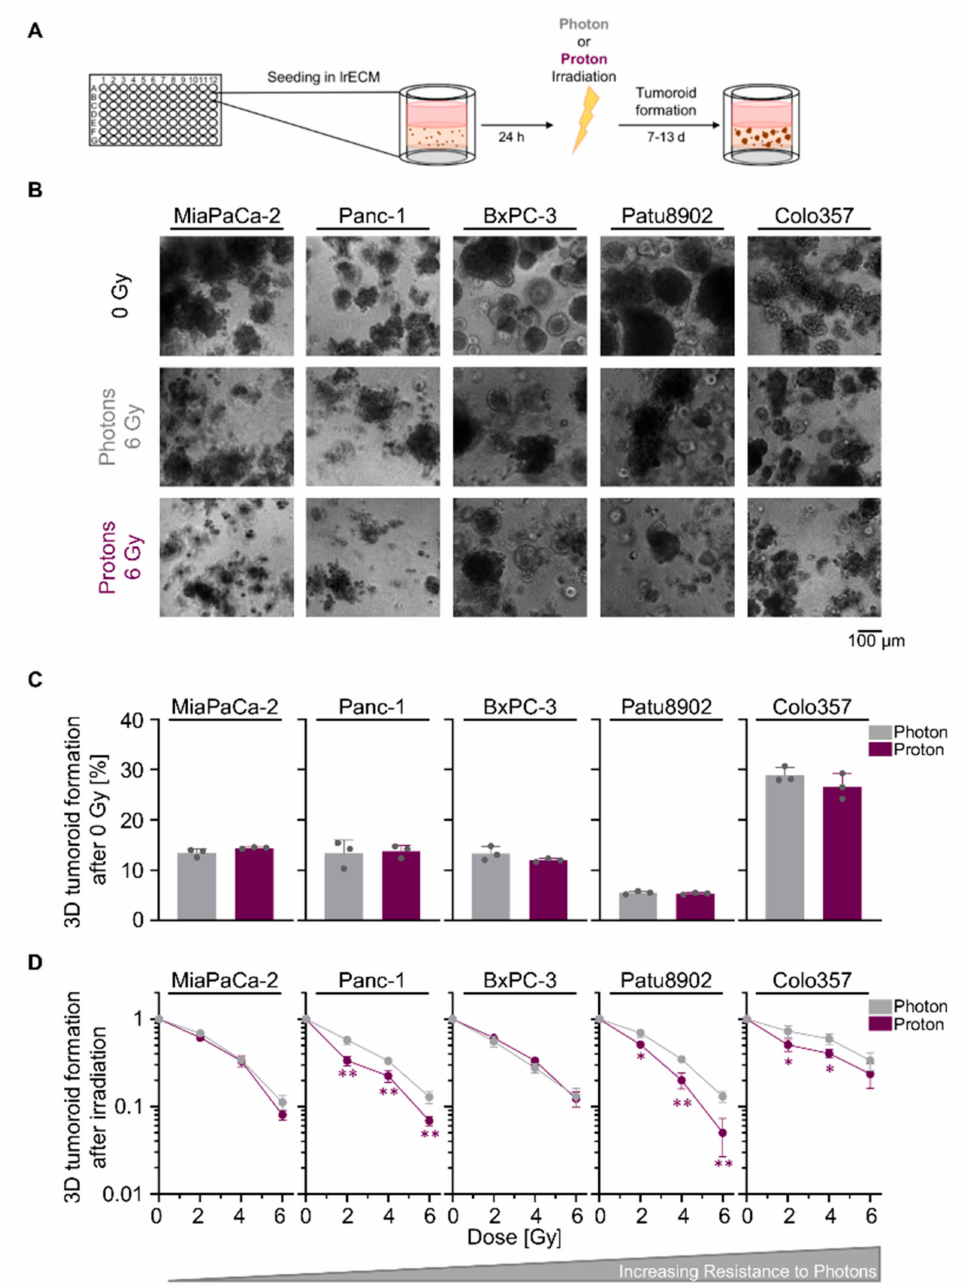
Figure 1. Proton irradiation tends to be more effective in reducing pancreatic ductal adenocarcinoma (PDAC) tumoroid growth than photon irradiation. ( A ) Experimental set-up for examining 3D PDAC tumoroid growth; ( B ) Representative bright-field images of unirradiated, 6-Gy photon and 6-Gy proton irradiated 3D PDAC tumoroids, scale bar: 100 µ m; ( C ) 3D tumoroid formation capacity without irradiation; ( D ) 3D PDAC tumoroid growth after irradiation with 2, 4, or 6 Gy of photons and protons. Cell lines are ordered by increasing resistance to photon irradiation. Results show mean ± SD ( n = 3; two-sided t -test; *, p < 0.05; **, p <